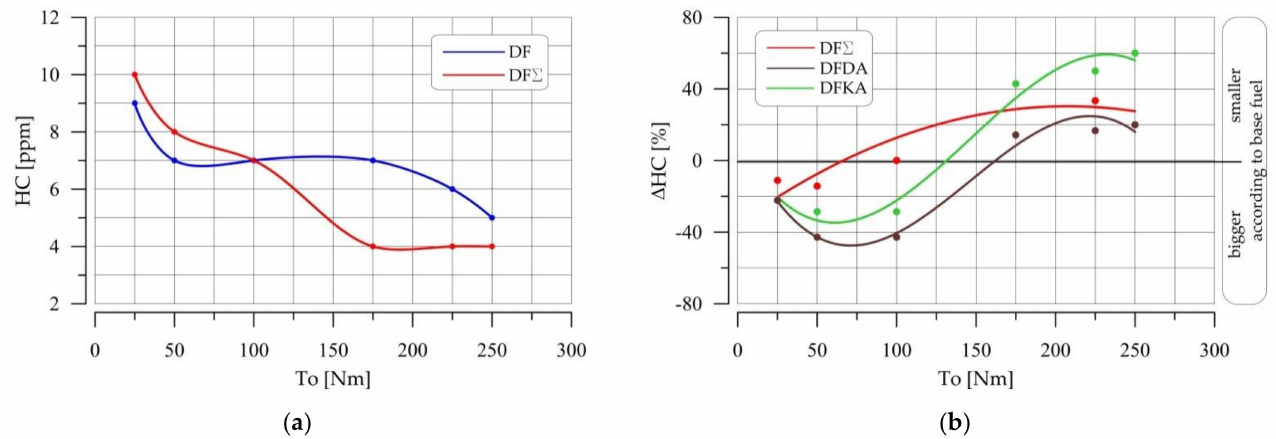
Figure 11. ( a ) The concentration of HCs in the exhaust fumes vs. engine torque; ( b ) Percentage difference in the concentration of HCs in the exhaust fumes vs. engine torque in relation to the base